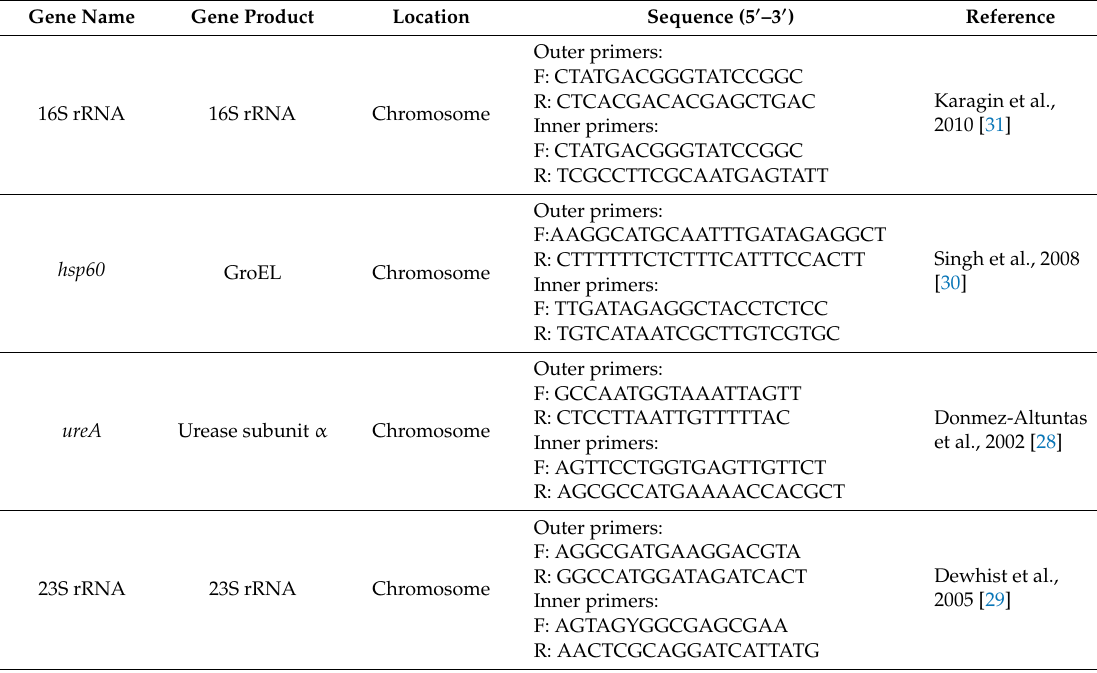
Table 2. PCR primers for Helicobacter pylori